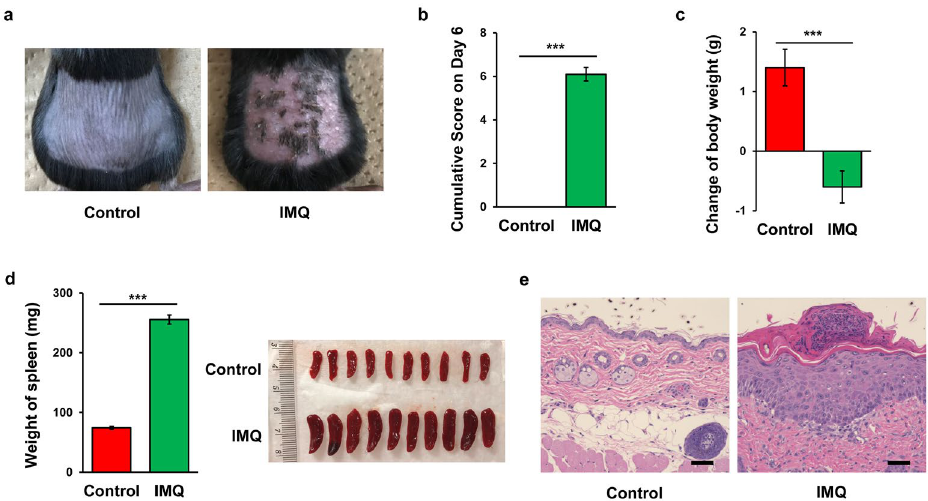
Figure 1. IMQ-induced psoriasis-like model. ( a ) Mice were treated topically with 5% IMQ cream or control cream on the shaved backs for five consecutive days. The representative photos of back skin from the two groups. ( b ) Cumulative score on day 6 of two groups ( P < 0.001). ( c ) Change of body weight for the two groups ( P < 0.001). ( d ) Weight of spleen ( P < 0.001). The photos of spleen from the control and IMQ group. ( e ) HE staining of the back skin of the two groups. Scale bar = 50 μm. The values represent the mean ± S.E.M. (n = 10). *** P <